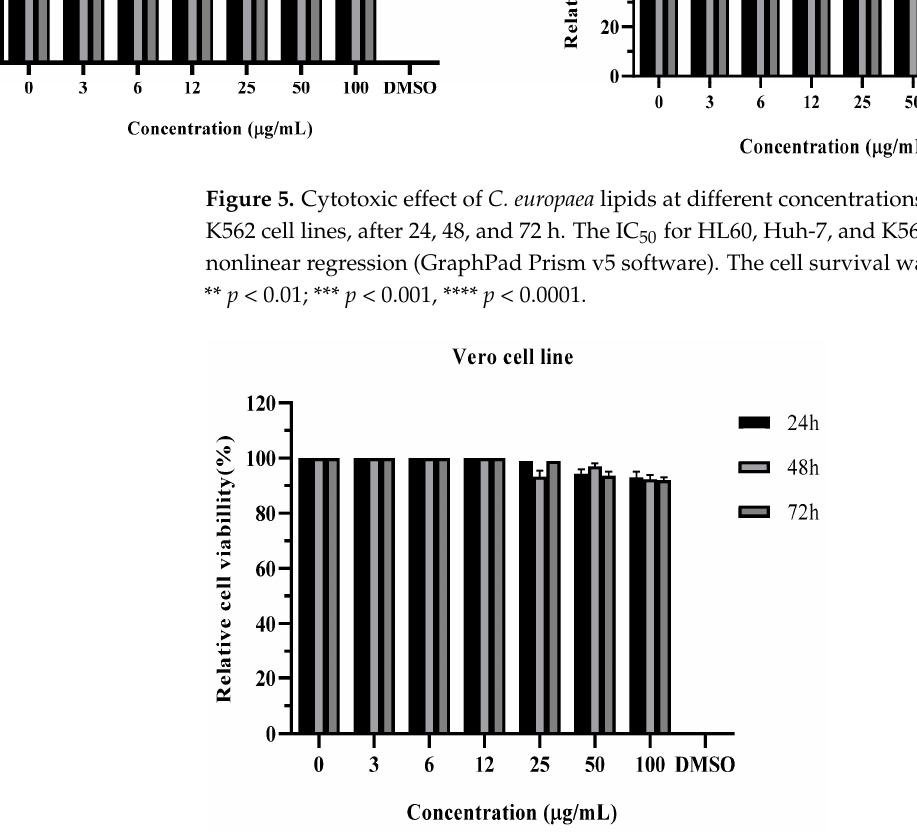
Figure 6. Cytotoxicity of C. europaea lipid extract at different concentrations against normal Vero cells, after 24, 48, and 72 h. The cell survival was evaluated using the MTT test. Table 3. Cytotoxicity of C. europaea lipids.